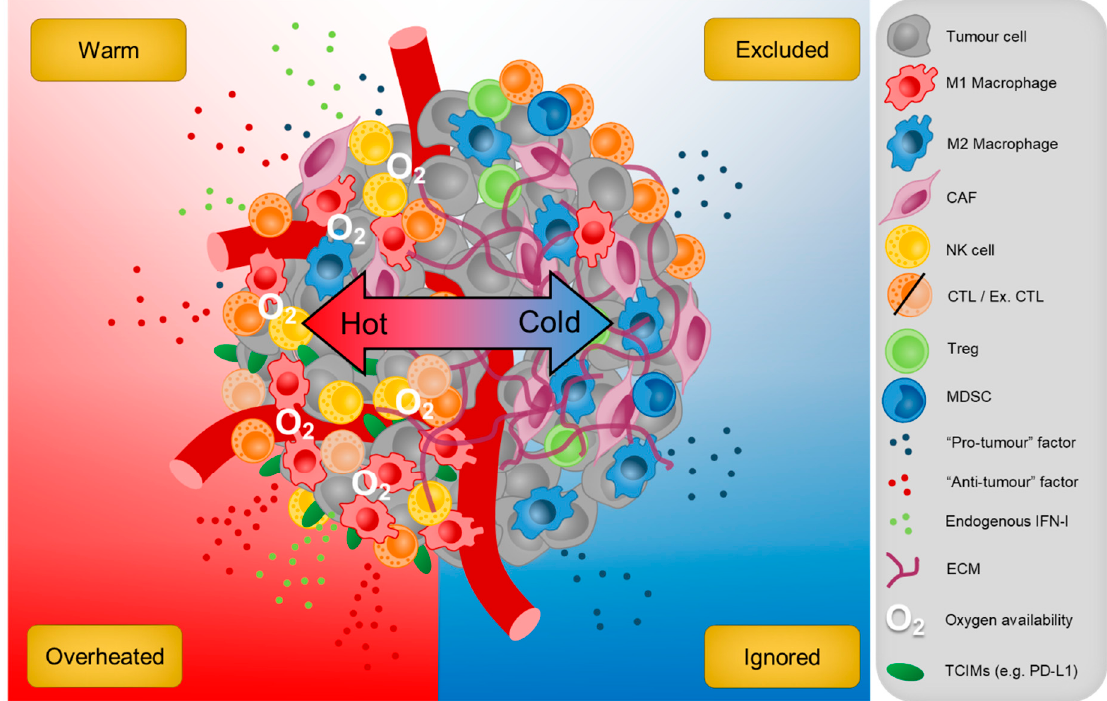
Figure 4. The cellular composition of ‘hot’ and ‘cold’ tumours. Anti-tumour immunity in the TME depends on the presence of CTLs that are activated by endogenous IFN-I and other pro-inflammatory stimuli produced by neighbouring cells. However, these can be subverted by an imbalance of anti-inflammatory factors that also reduces their trafficking to the tumour site. Conversely, too much inflammation may impair the cytolytic activities of CTLs, triggering immune escape. This intense inflammation mediated by conventional anti-tumour factors such as IFN-Is also upregulate T cell inhibitory molecules (TCIMs) on tumour cells that drive the adaptive resistance to